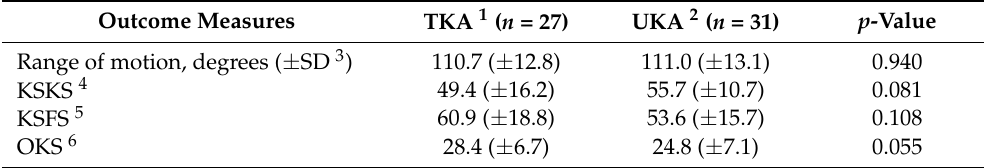
Table 2. Pre-operative Range of Motion and Functional Scores.